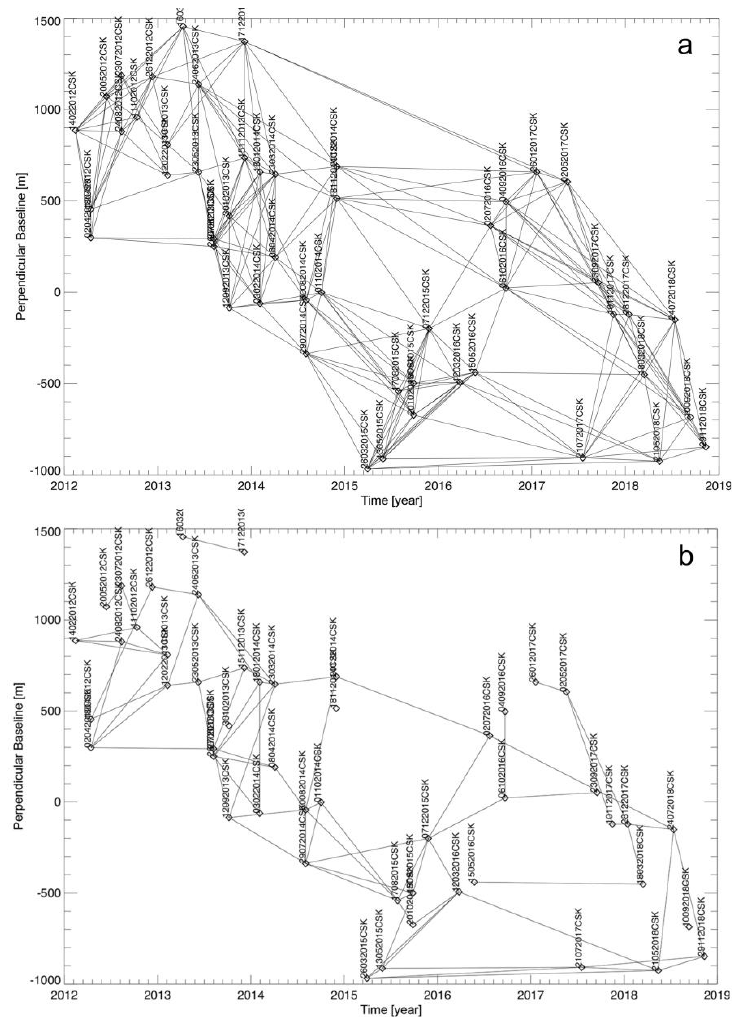
Figure 4. The adaptive SAR distributions in the temporal/perpendicular baseline planes relative to two given SAR pixels. The adaptive network in ( a ) consists of 242 InSAR data pairs, whereas that shown in ( b ) consists of 77 InSAR data